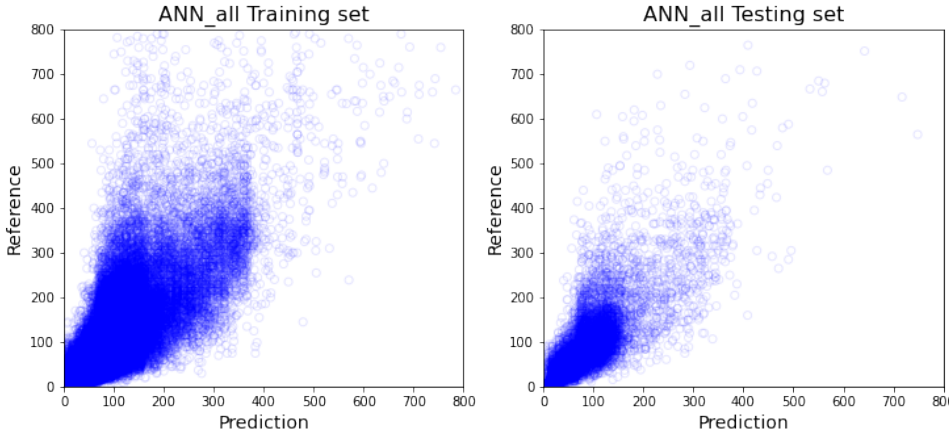
Figure 8. All-inclusive model with ANN (The visualization of training and testing data for all- inclusive model with